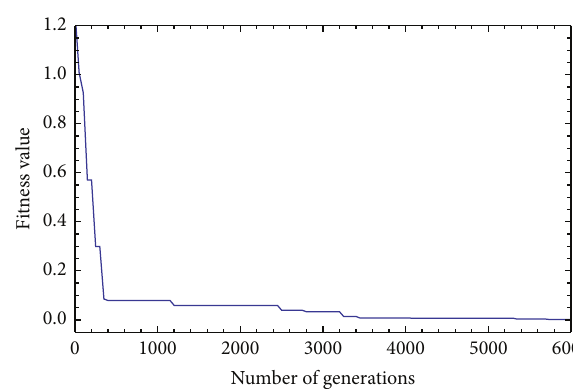
Figure 15: Performance graph for Case